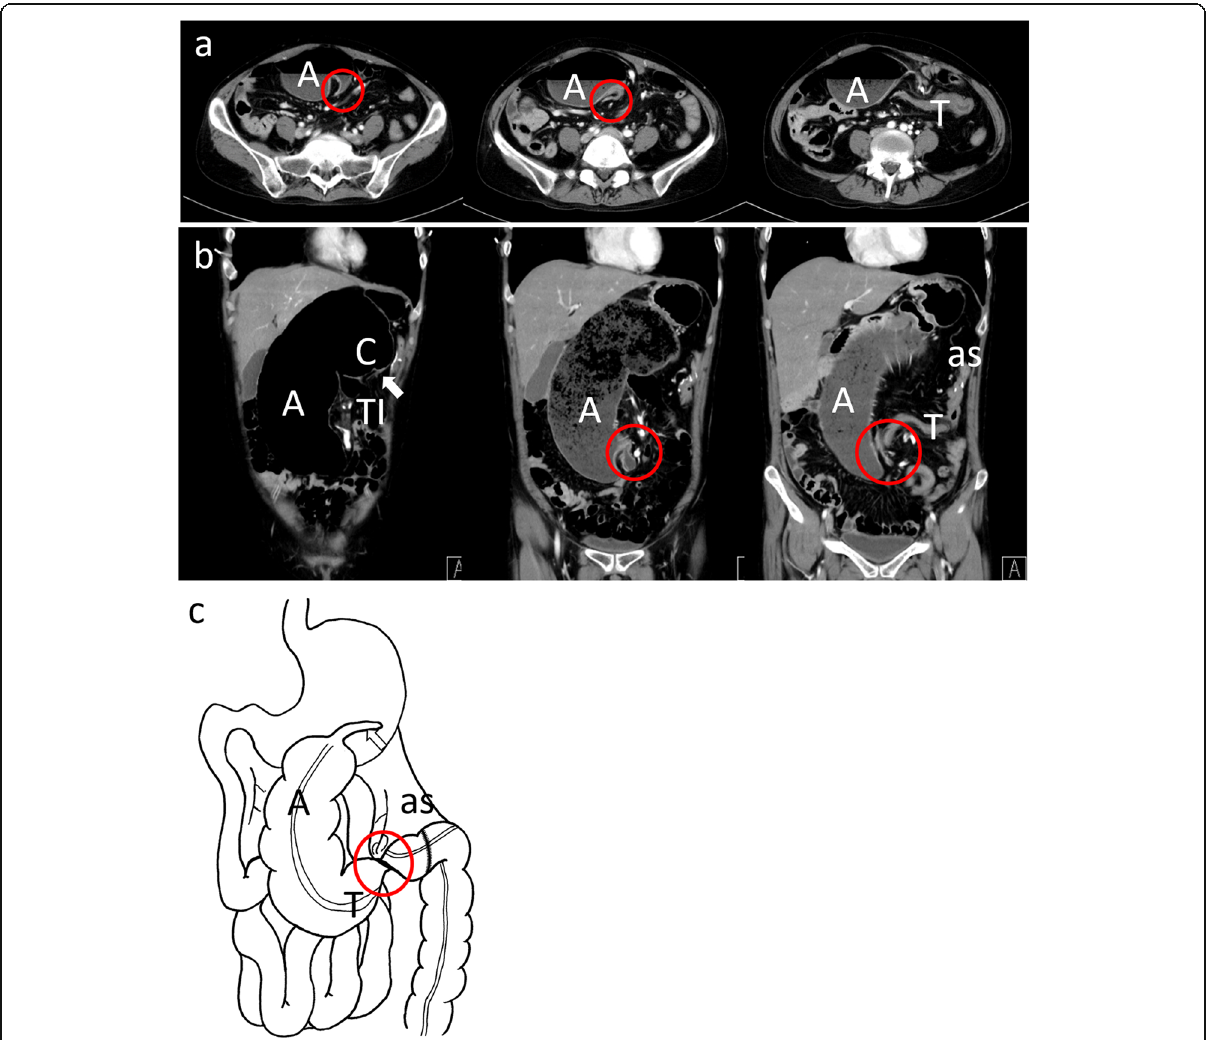
Fig. 4 Enhanced computed tomography before the second surgery. Transverse section ( a ) and coronary section ( b ) images show the enlarged cecum (C) and ascending colon (A). The obstructive point was on the remaining transverse colon with a whirlpool sign (red circle). The anastomotic site of the first surgery (as) was placed in the left upper abdominal cavity. The appendix (white arrow) was in the upper abdominal cavity. The volvulus and the distribution of the gastrointestinal tract are indicated in ( c